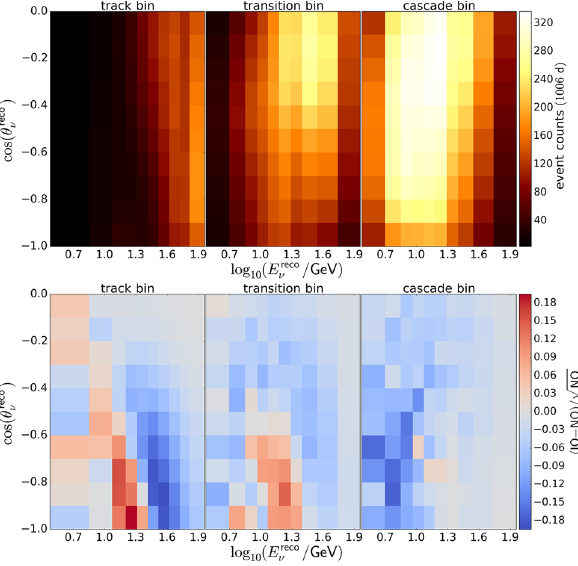
Fig. 4 Comparisonof Monte Carlotemplatefor atmospheric muons in Analysis A , generated as histogram (top) and KDE (bottom): the latter one is used in the analysis, due to the reduced impact of limited Monte Carlo statistics